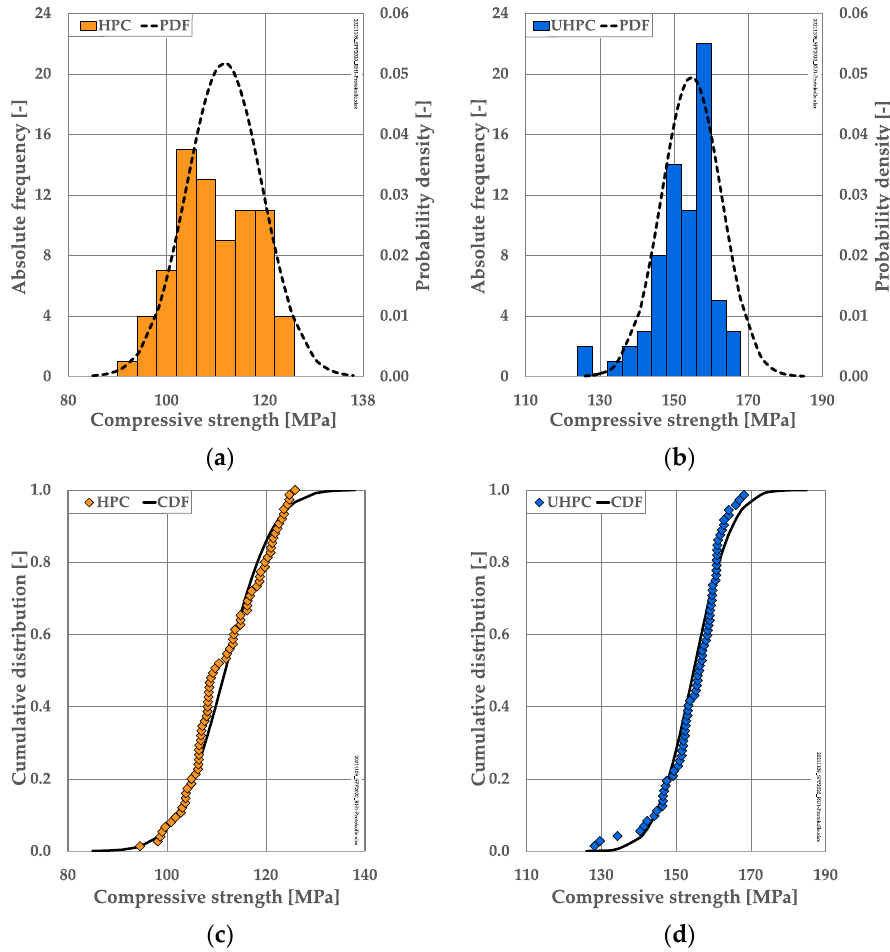
Figure A2. Absolute frequency and probability density for the ( a ) HPC and ( b ) UHPC. Cumulative distribution for the ( c ) HPC and ( d ) UHPC.